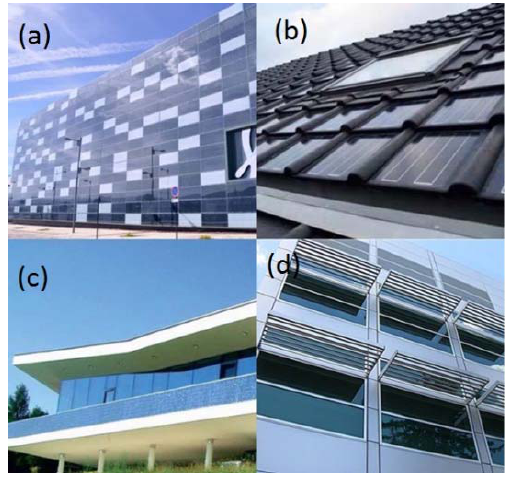
Figure 1. Building integrated photovoltaic (BIPV) integration in ( a ) facade; ( b ) rooftop; ( c ) spandrels and parapets; ( d ) sun shading. Reproduced from [8,10,11].